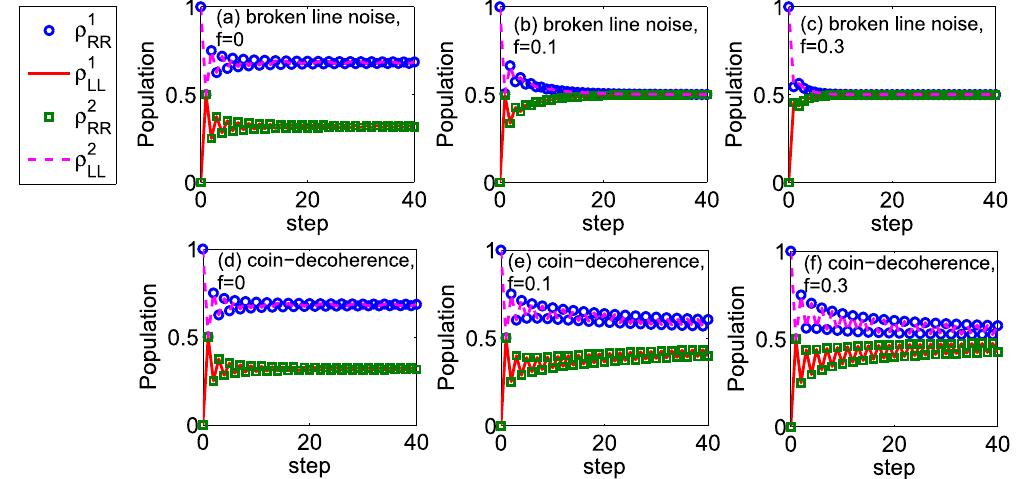
Figure 5. The populations of the coin in the two dimensional QW with different decoherence strengths. Blue circles and red solid lines stand for the populations of the coin at the state | R 〉 and | L 〉 , respectively; the initial state of the coin is ρ = R R (0) . Green rectangles and magenta dashed line depict the populations of the coin 1 at the states | R 〉 and | L 〉 , respectively; the initial state of the coin is ρ = L L (0) . ( a – c ) The broken line noise is 2 considered in the walk. ( d – f ) The coin-decoherence emerges in the